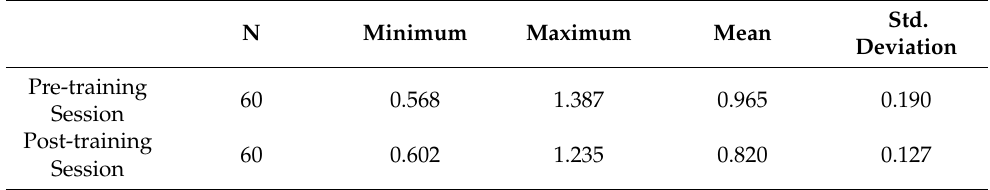
Table 6. In-game reaction time of the participants.